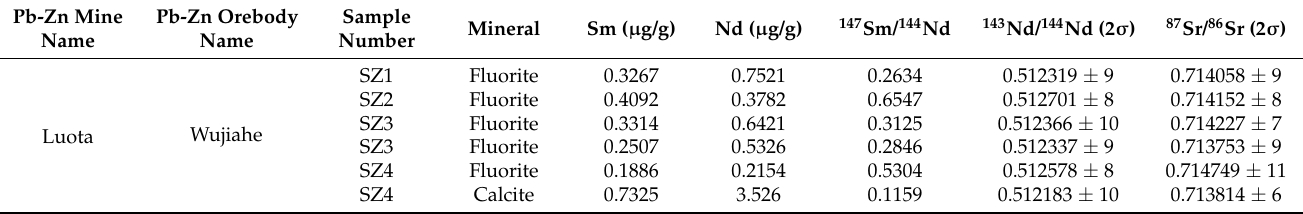
Table 4. Sm-Nd and Sr isotopic compositions of fluorites and paragenetic calcite from the Luota MVT Pb-Zn